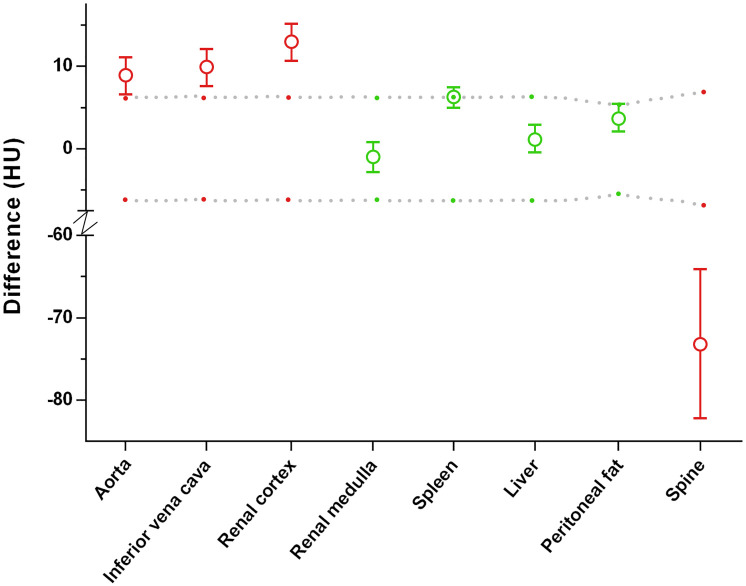
Quantitative differences between VUE and TUE images, based on measured CT numbers.y-axis represents differences in CT number (HU) for VUE minus TUE. Red and green symbols represent the measured differences and 95% CI in CT numbers between VUE and TUE images. Gray dots reflect the calculated boundary of clinical equivalence between VUE and TUE (see text for explanation). Green symbols indicate that the measured difference between VUE and TUE lies within the calculated threshold range of equivalence. Red symbols indicate that the measured difference between VUE and TUE images is significantly greater than (i.e. outside) the calculated threshold difference of equivalence.